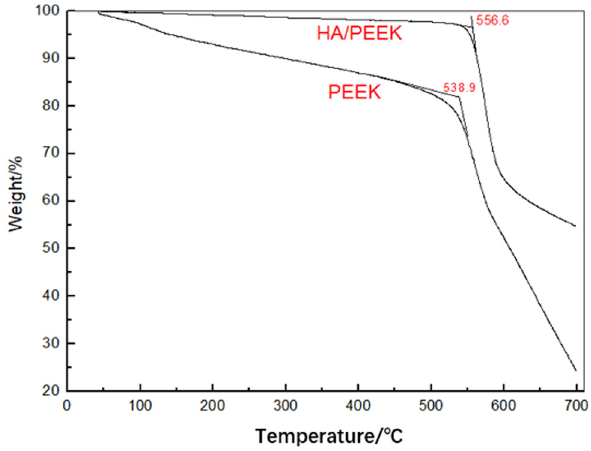
Figure 3: TGA for pure PEEK and HA/PEEK nanocomposite ( containing 2.5 wt% - modi fi ed HA )